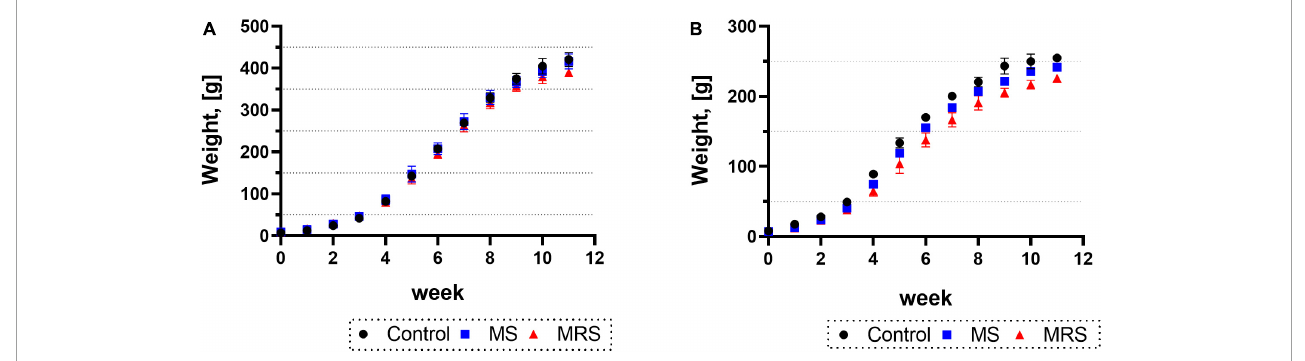
FIGURE2 Comparison of the body weights in control, MS, and MRS group [ (A) male and (B) female]. Data are presented as means ± SD ( n = 6).